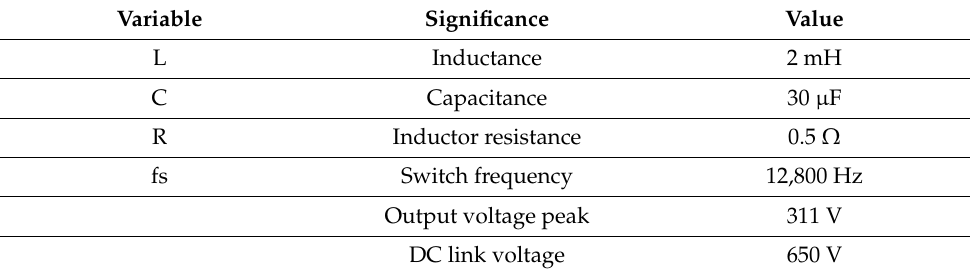
Table 2. Parameters of the three-phase invert.